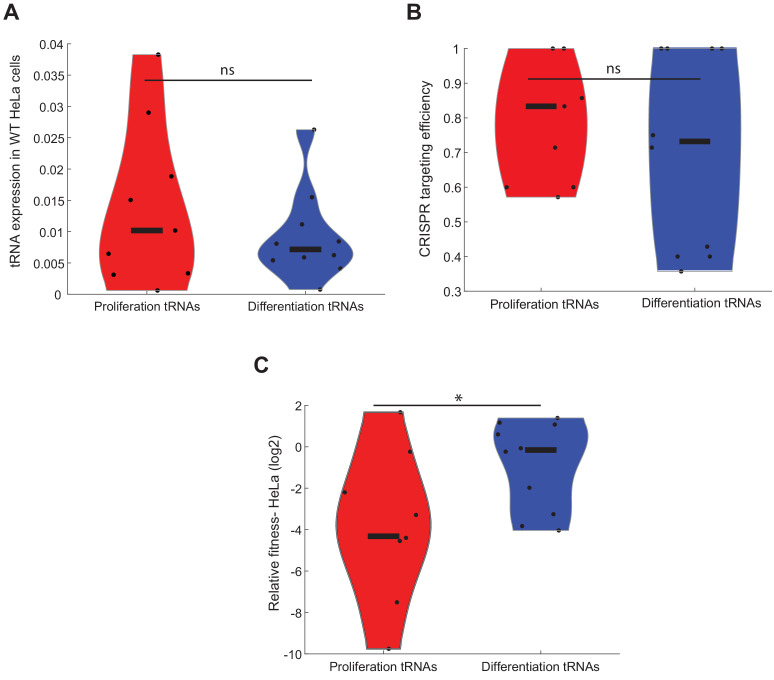
Comparison of tRNA expression, targeting efficiency and relative fitness between differentiation and proliferation-tRNAs.Comparisons of (A) tRNA expression level in WT cells, (B) targeting efficiency, and (C) relative fitness between targeted proliferation and differentiation-tRNAs in HeLa cells. Each dot depicts a single tRNA family. Wilcoxon rank-sum test was conducted to examine significance of difference between the distributions (* indicates p<0.05, ns indicates non- significant p value).